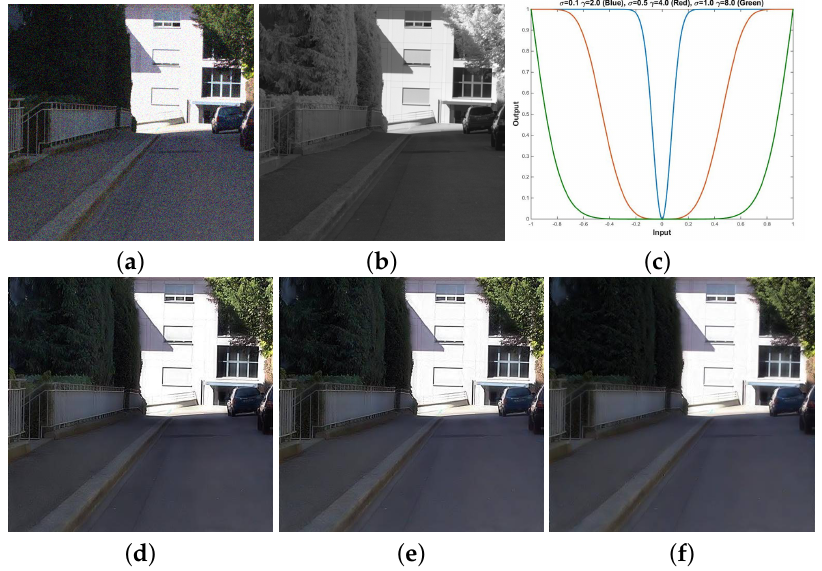
Figure 13. Fusion results from the MFD framework with different σ 1 and γ 1 pairs in the contrast preservation term. ( a ) Noisy RGB image. ( b ) NIR image. ( c ) Transfer function (blue, red, and green curves corresponding to ( d – f )). ( d ) σ 1 = 0.1 and γ 1 = 2.0. ( e ) σ 1 = 0.5 and γ 1 = 4.0. ( f ) σ 1 = 1.0 and γ 1 = 8.0.